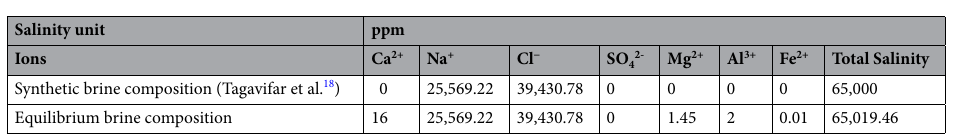
Table 5. Compositions of equilibrium brine used in this work versus synthetic brine used by Tagavifar et al. 18 .